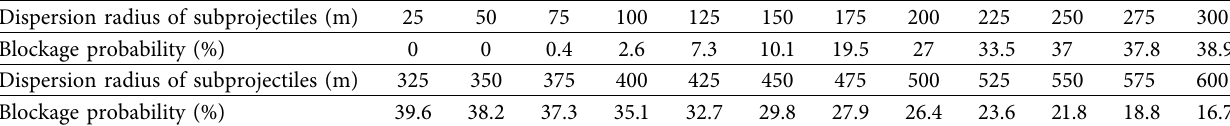
Table 7: Influence of the dispersion radius of subprojectiles on the blockage probability. Dispersion radius of subprojectiles (m)